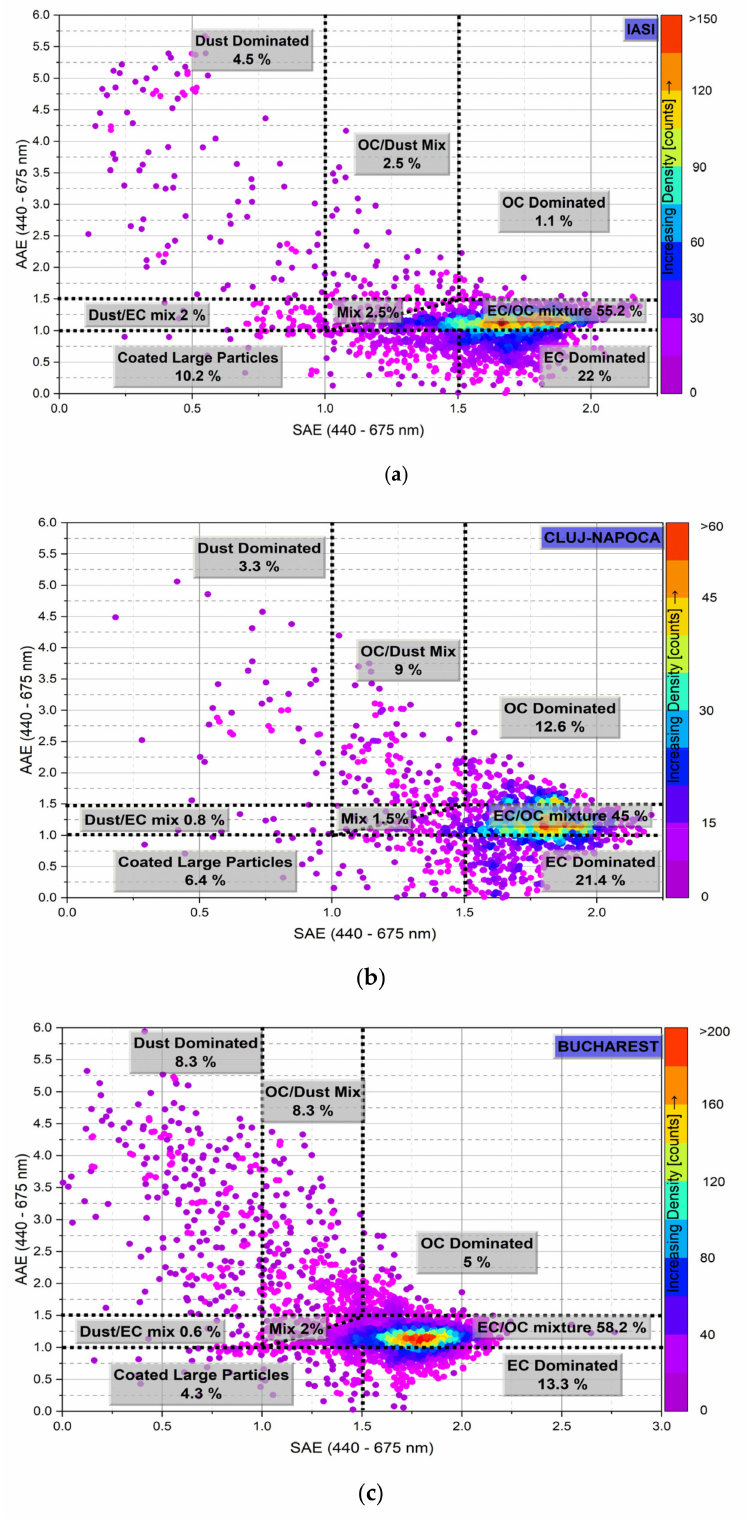
Figure 7. Division of the Absorption Ångström Exponent [AAE at 440–675 nm] Scattering Ångström Exponent [SAE at 440–675 nm] in the number density plot [March of 2015–July of 2018] from ( a ) Iasi, Iasi_LOASL monitoring site ( b ) Cluj–Napoca, Cluj_UBB monitoring site, and ( c ) Bucharest, Magurele_INOE monitoring